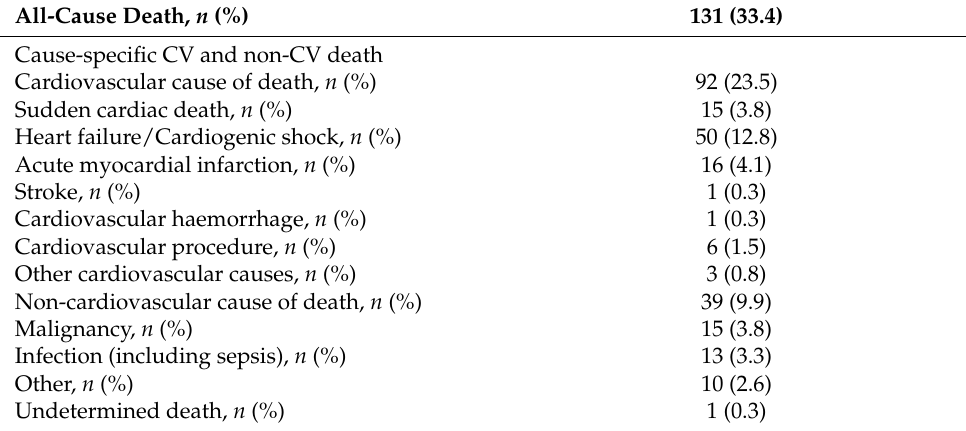
Table 2. Rates of all-cause, cause-specific cardiovascular death and non-cardiovascular death.